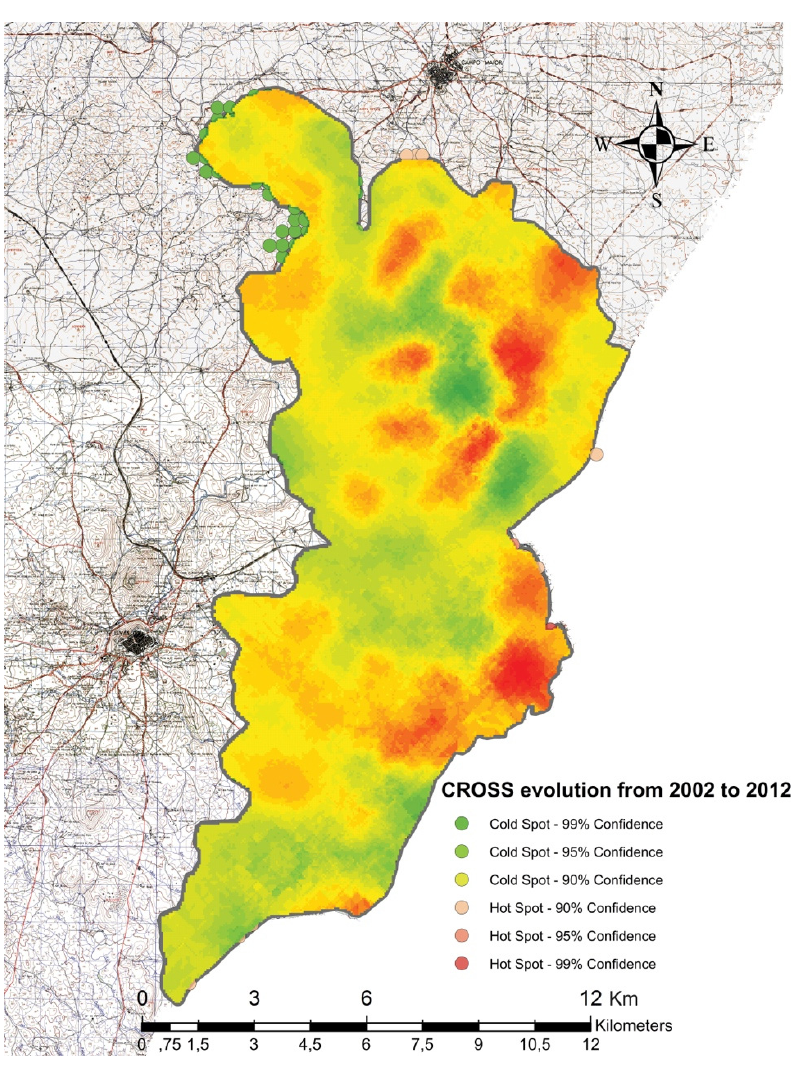
Figure 7. Predictive + Hotspot map of CROSS evolution in the studied area from 2002 to 2012.